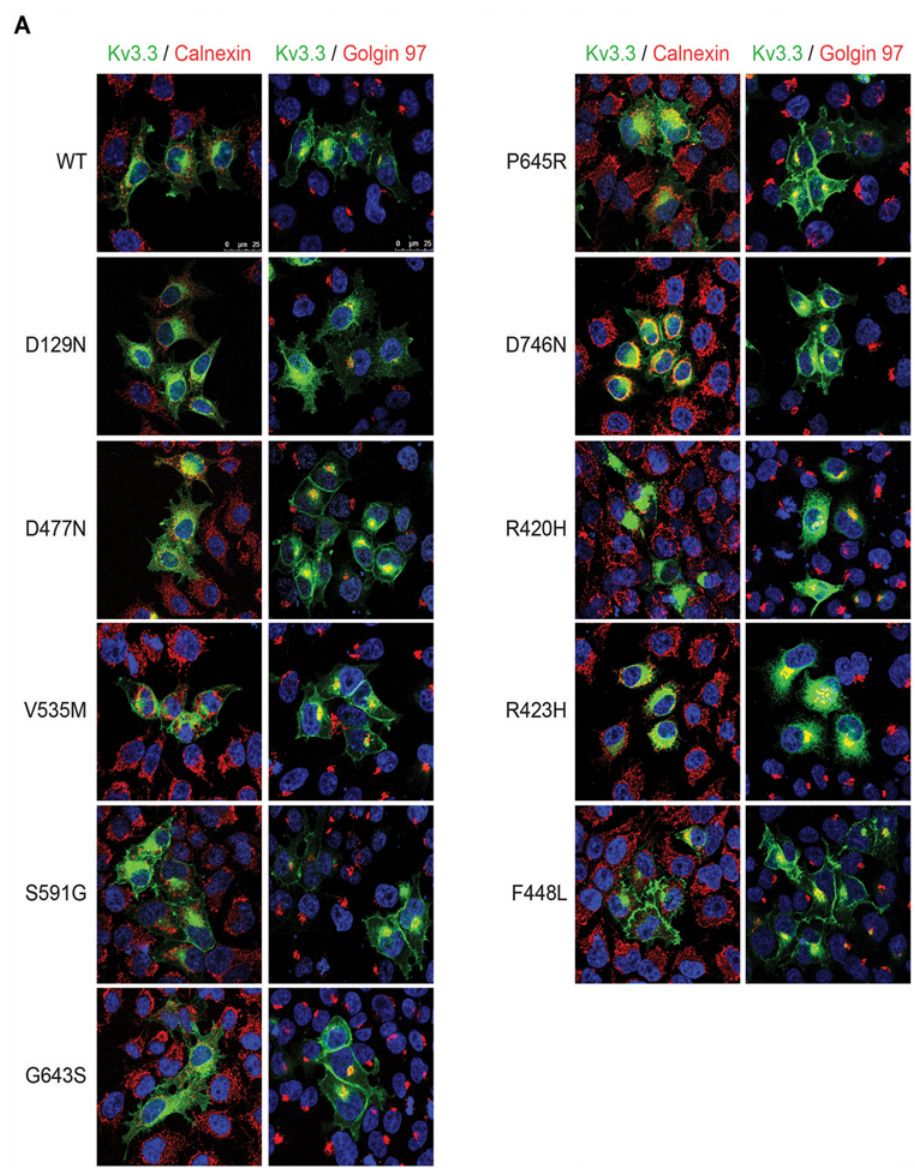
Fig 1. Subcellular localization and trafficking of Kv3.3 WT and mutants. Confocal images showing HeLa cells expressing EGFP-Kv4.3 WT or carrying the genetic variants (green) stained with anti-Calnexin (endoplasmic reticulum) and anti-Golgin97 (Golgi apparatus) (red), and Dapi (nucleus; blue). Scale bar, 25 μ m.